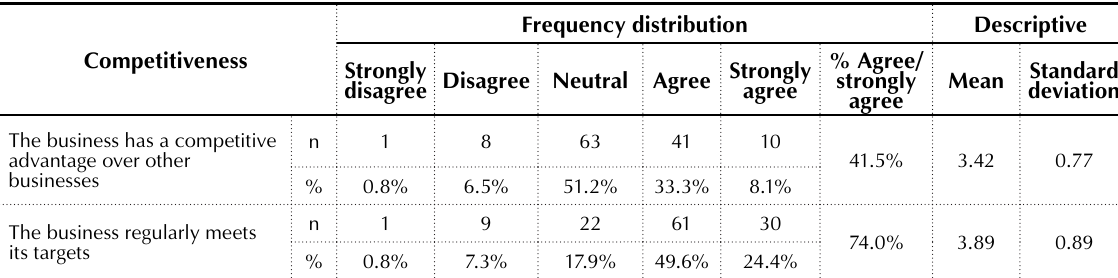
Table 6. Competitiveness of tourism